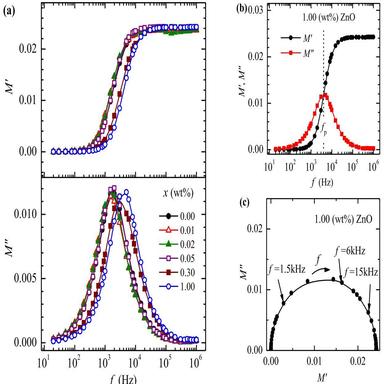
(a) Complex electric modulus (M0 and M00) versus frequency (f) plots for the GLY/x (wt%) ZnO nanofluids (x = 0.00, 0.01, 0.02, 0.05, 0.30, and 1.00) at 25 C, (b) simultaneous representation of M0 and M00 versus f, and (c) Debye type complex plane plot (M00 versus M0 ) for the GLY/1.00 (wt%) ZnO nanofluid, at 25 C.